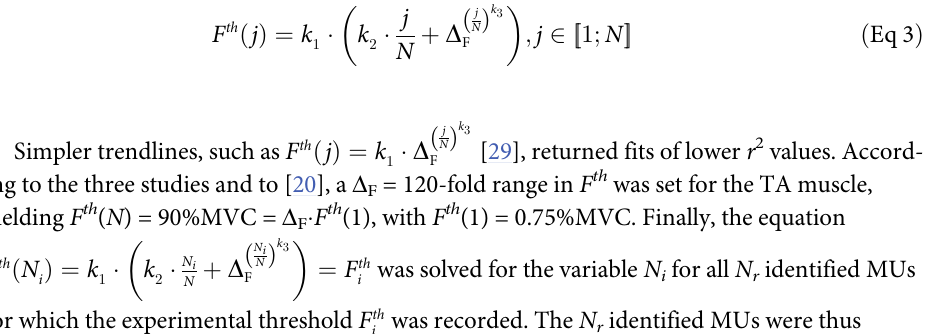
that describe the trapezoidal shape of the muscle isometric contraction. tr i